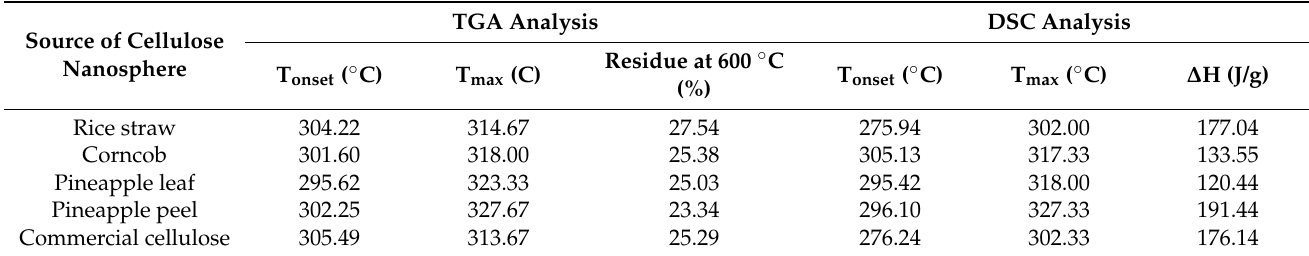
Table 2. Thermal properties of cellulose nanosphere from different sources compared with commercial